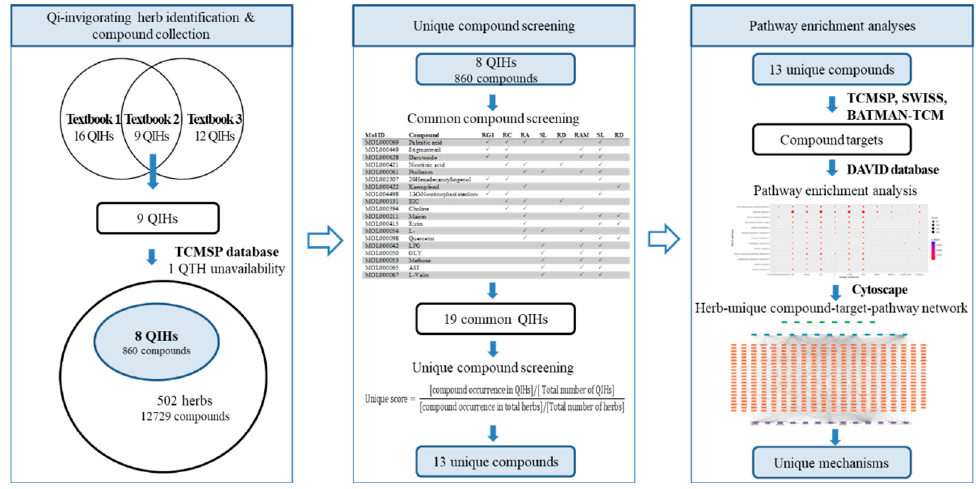
Figure 1. Flow chart of study.